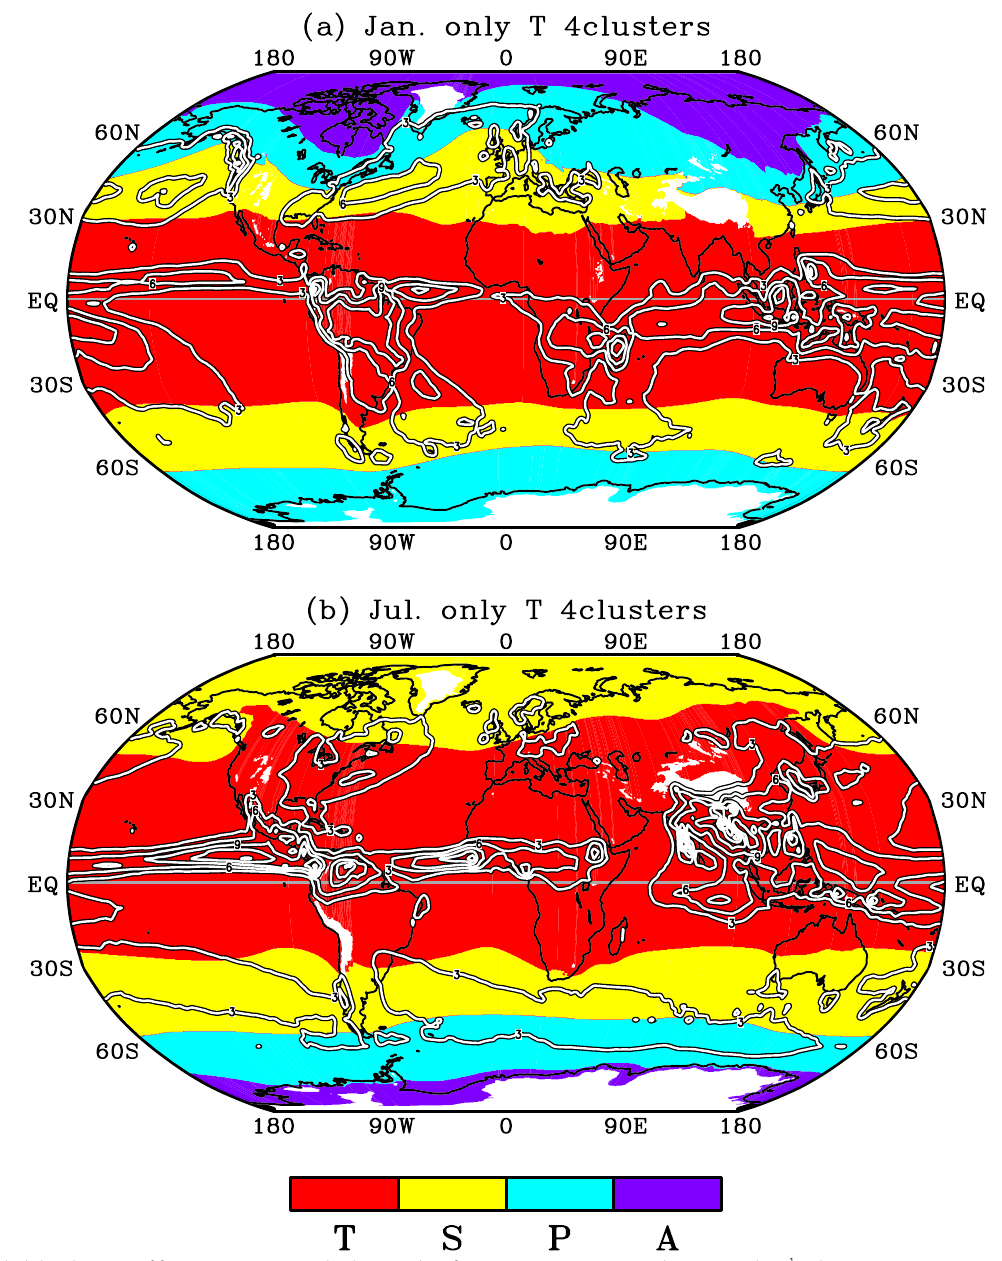
Fig. 8 Global distributions of four air mass zones (shading) and surface precipitation greater than 3 mm day − 1 (white contour) in ( a ) January and ( b ) July. The contour interval is 3 mm day − 1 . The blank areas mean the same as in Fig. 5. T: Tropical, S: Subtropical, P: Polar, A: